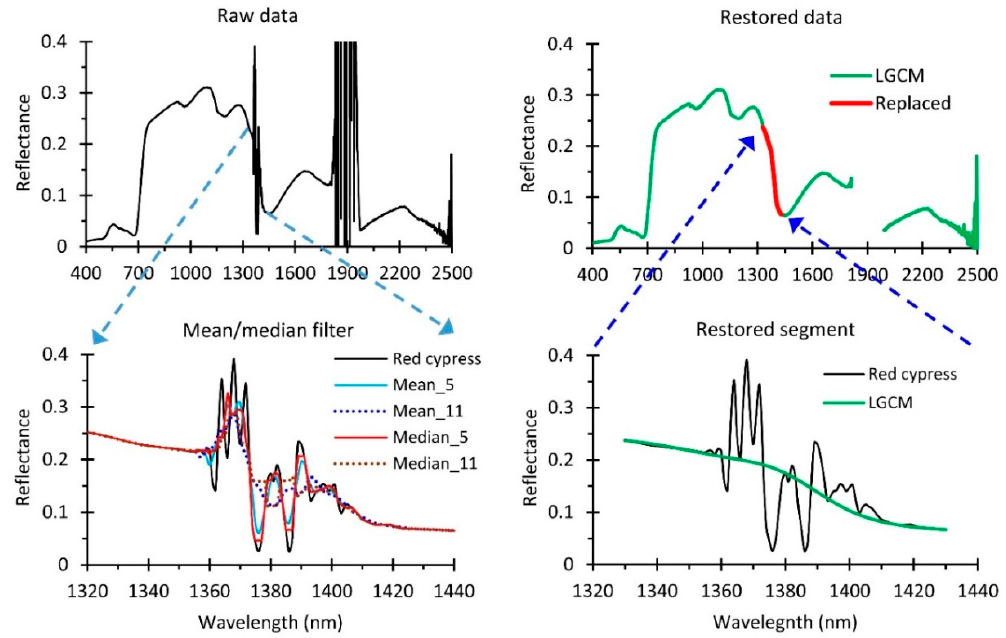
Figure 2. A conceptual diagram of the Logistic-Gaussian complex signal model (LGCM) method for restoring short-wave infrared (SWIR) signal. The subfigures on the upper and lower left show the raw data of the in-field spectra of a red cypress tree and the mean/median filter processed SWIR spectra. The noisy reflectance is replaced by the LGCM restored SWIR signals (Lower right) to redraw the red cypress reflectance curve (upper right).